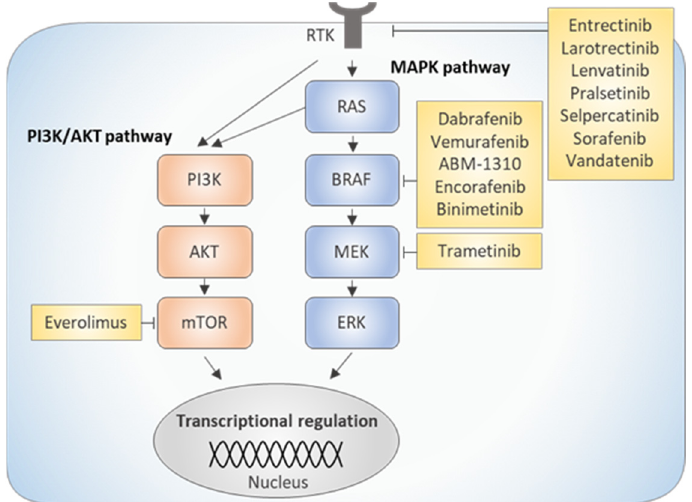
Figure 2. Schematic representation of major molecular targets in kinase inhibition-based therapies for thyroid cancer. RTK, receptor tyrosine kinase.